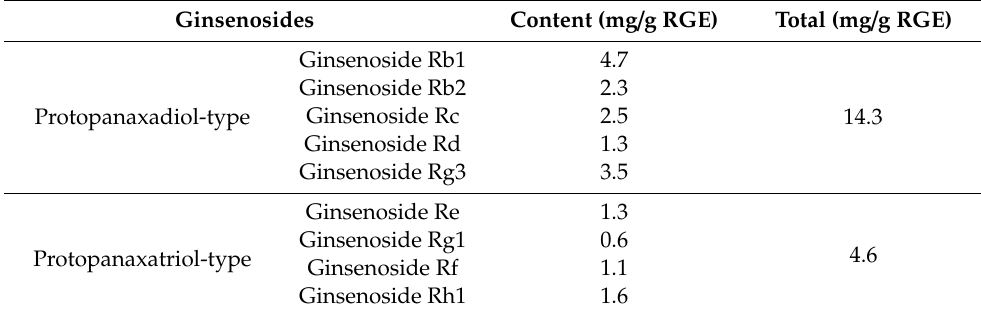
Table 1. Ginsenoside content in red ginseng extract (RGE)